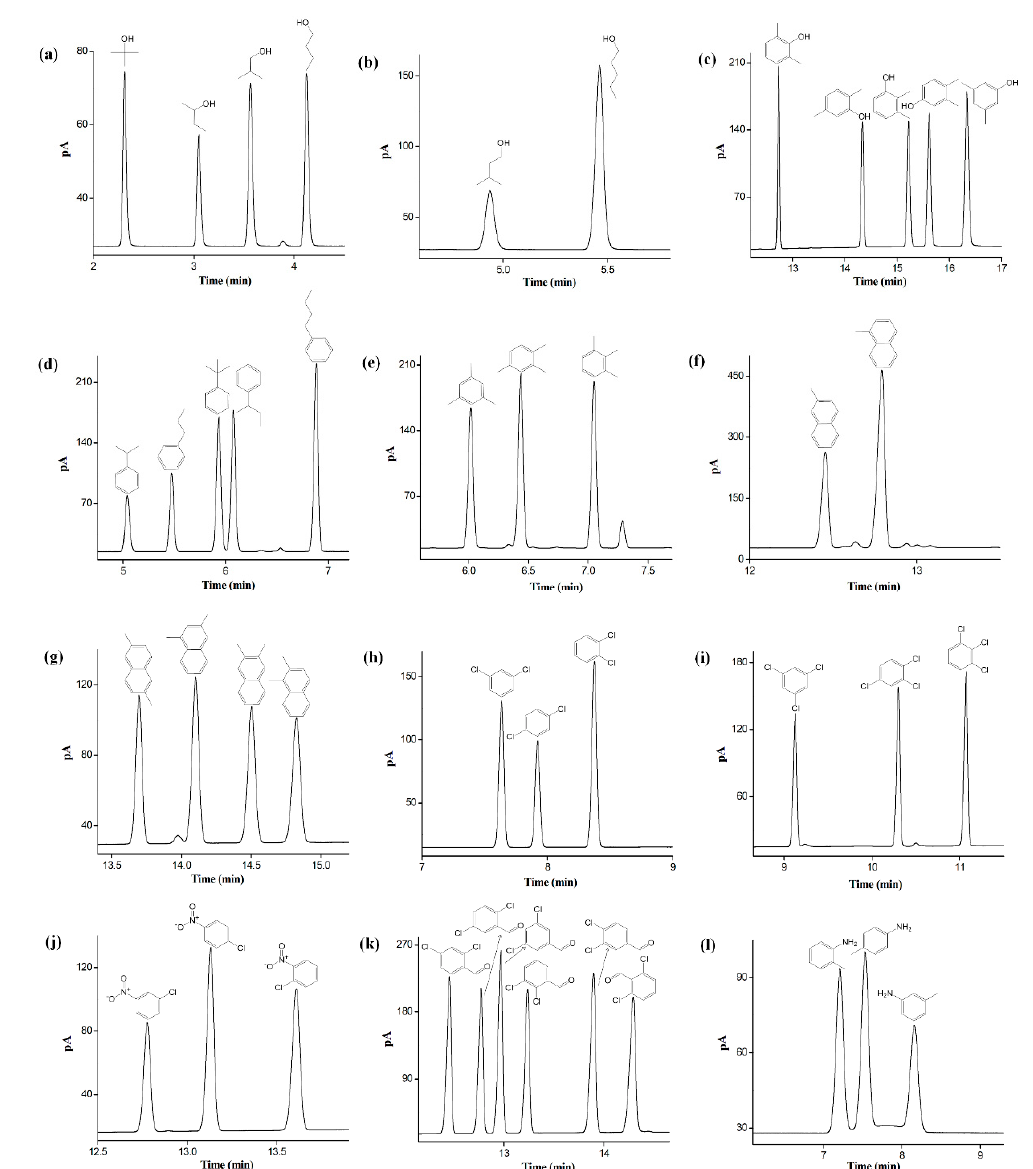
Figure 3. Separations of isomer mixtures of ( a ) butanol, ( b ) pentanol, ( c ) xylenol, ( d ) propylbenzene and butylbenzene, ( e ) trimethylbenzene, ( f ) methylnaphthalene, ( g ) dimethylnaphthalene, ( h ) dichlorobenzene, ( i ) trichlorobenzene, ( j ) nitrochlorobenzene, ( k ) dichlorobenzaldehyde, and ( l ) toluidine on the PCL-PEG-PCL column. Temperature program for (a–k) isomer mixtures: 40 °C(1 min) to 160 °C at 10 °C/min, flow rate at 0.6 mL/min. Temperature program for (l) toluidine isomers: 125 °C(10 min), flow rate at 0.6 mL/min.